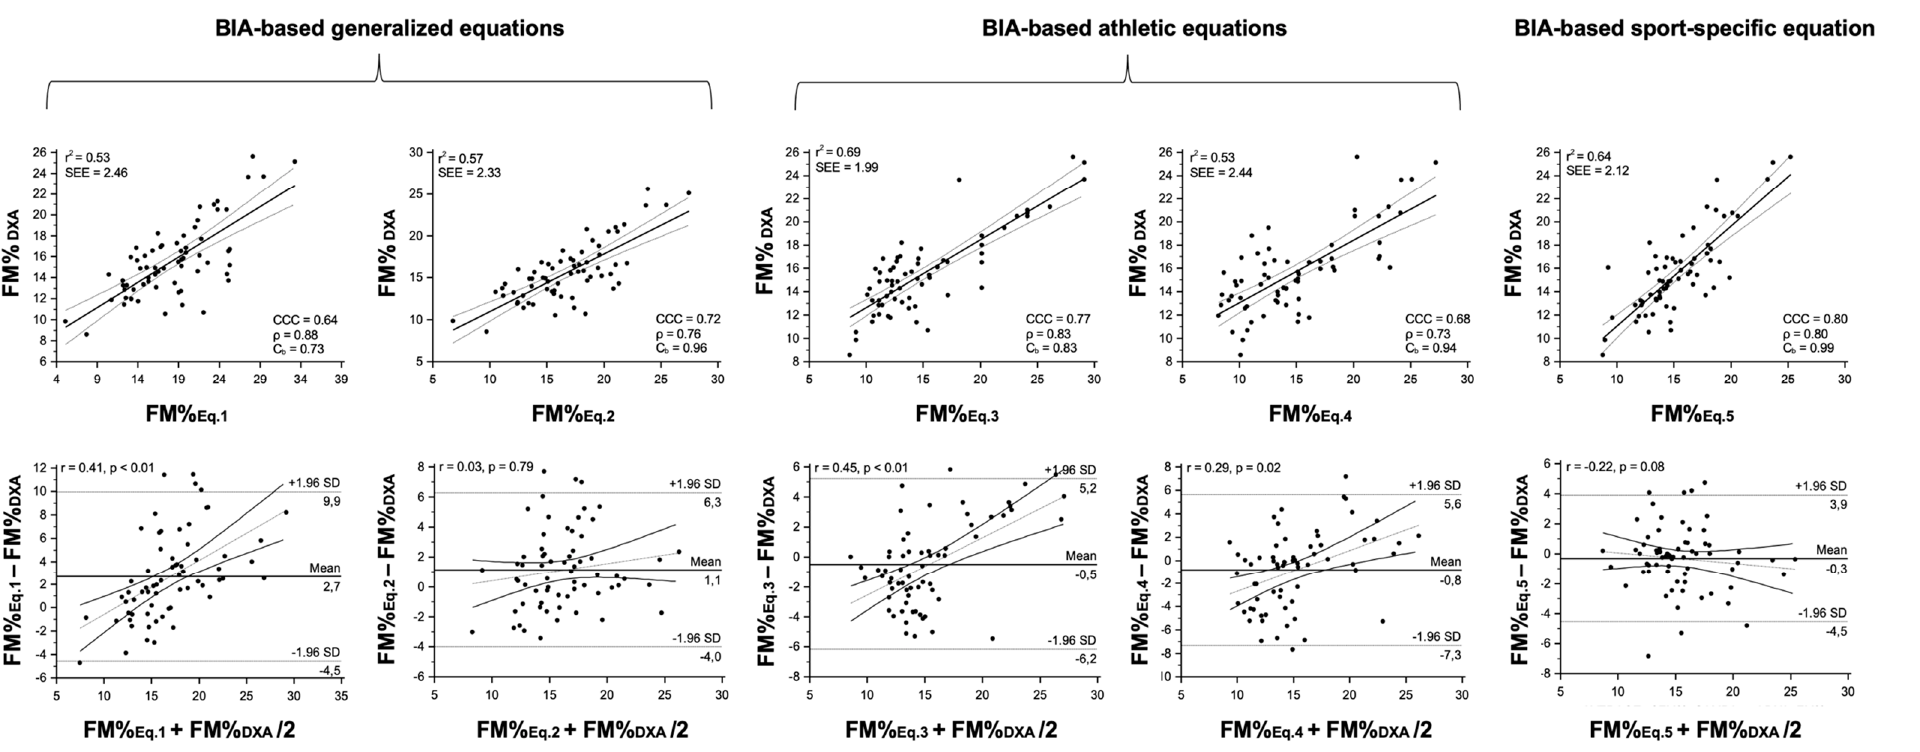
Figure 2. Results from regression, concordance, and agreement analyses between the percentage of fat mass (FM%) estimated from the selected BIA-based predictive equations and the reference method (DXA) in the futsal players. In the upper panel, the scatterplots show the relationship between the estimated and the reference FM% and the Lin’s concordance correlation coefficient (CCC), including precision ( ρ ) and accuracy (C b ) indexes. In the lower panel, the results of Bland–Altman analyses are shown. Eq. 1 = Lukaski and Bolonchuk [21]; Eq. 2 = Sun et al. [22]; Eq. 3 = Matias et al. [25]; Eq. 4 = Stewart et al. [26]; Eq. 5 = Matias et al. [ 29].